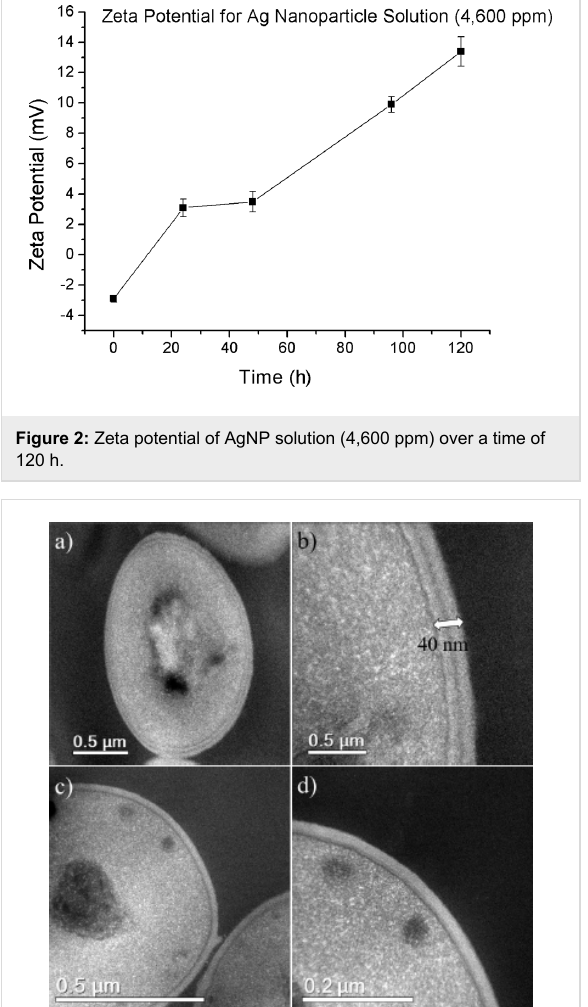
Figure 4: MSSA cell STEM image. (a) MSSA cell showing AgNP attachment on the cell wall. (b) High magnification STEM images of MSSA cell (1) wall teichoic acids ( ≈ 3 nm), (2) interaction of AgNPs with CWGs, (3) destabilization, (4) leakage of cytoplasmic material leading to bacterial cell lysis, (5) cytoplasm, (6) cytoplasmic membrane and (7) cell wall. The AgNP concentration was 11.5